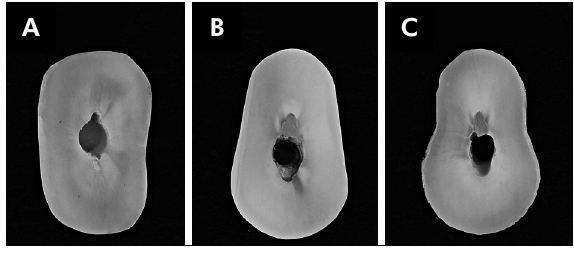
Figure. Example photographs of the failures: (A) adhesive failure, (B) cohesive failure, (C) mixed failure.